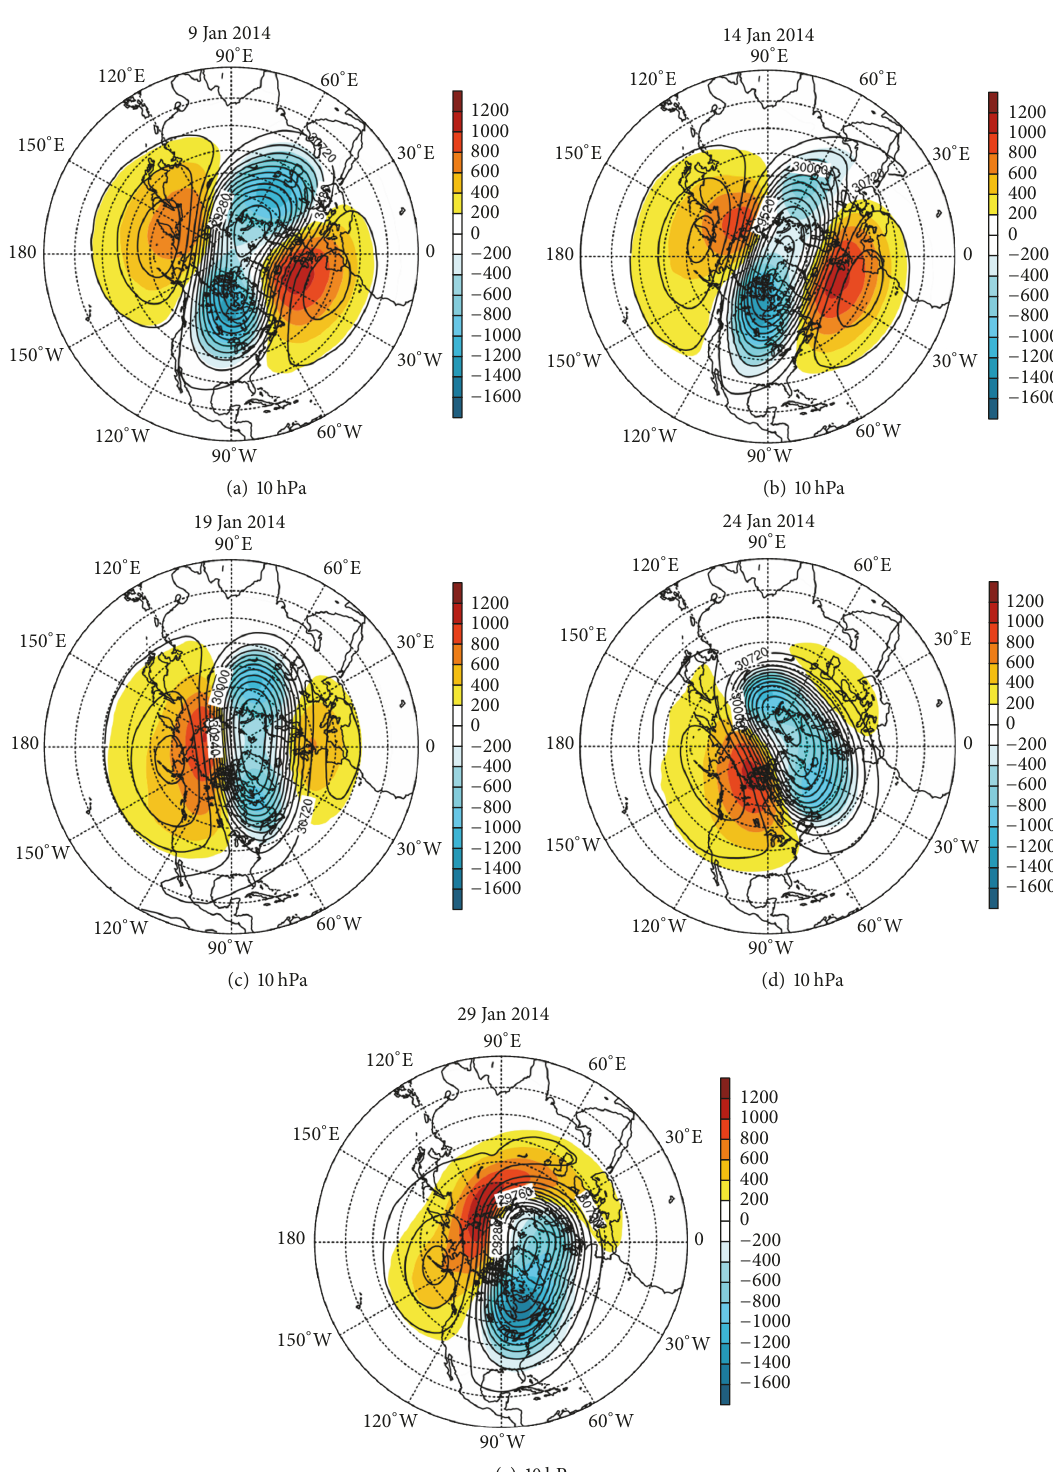
Figure 3: Daily geopotential height (contours; gpm) and its anomaly (shading; gpm) at 10 hPa in January 2014 relative to the 30-year climatology. The 30-year climatology refers to the 30-year average of January in 1981–2010. Contour interval: 240